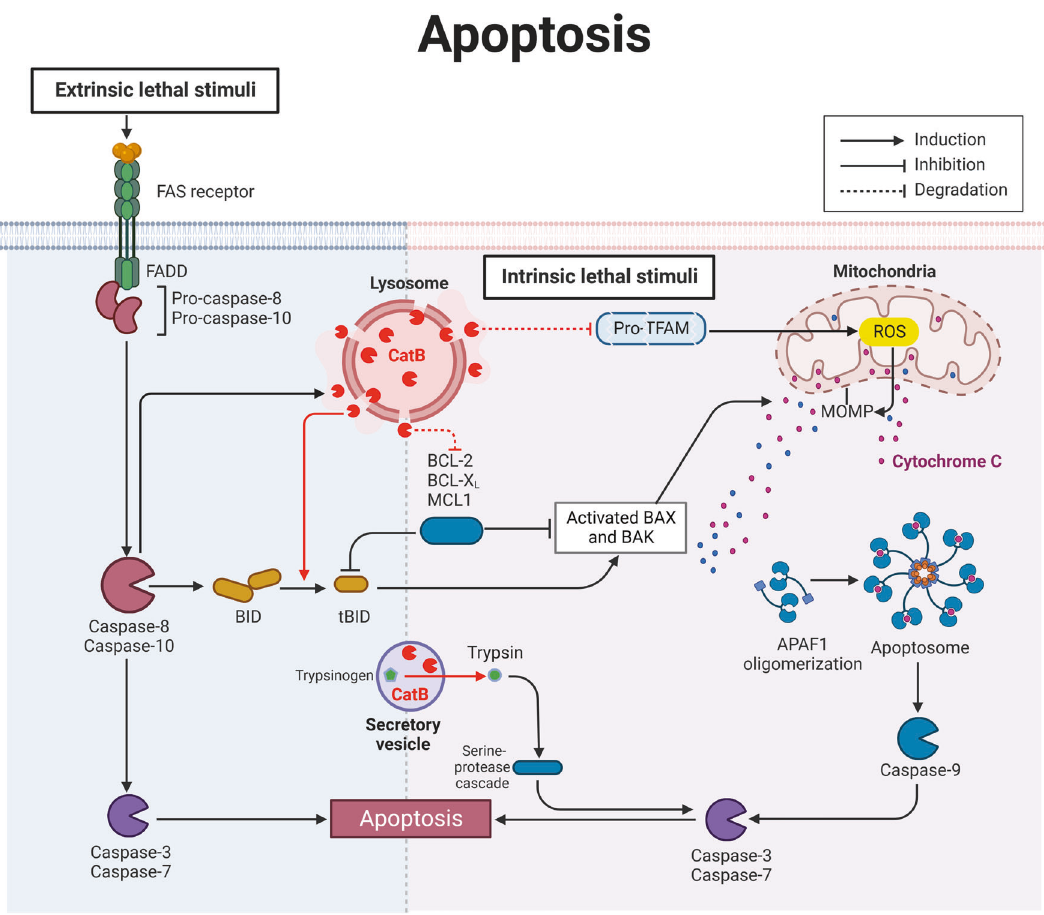
Fig. 2 Schematic representation of CatB and its substrates in the core apoptotic machinery. The extrinsic apoptotic pathway is activated by the binding of Fas ligand to the cell surface death receptor (FasR), which induces the activation of the caspase cascade. The intrinsic apoptotic pathway is activated by intracellular stress, which is initiated by BCL-2 family proteins (BAX/BAK). Mitochondria release cytochrome c. The binding of cytochrome c to APAF1 promotes apoptosome assembly, which recruits and activates caspase 9. Notably, leakage of CatB from the lysosome involves in TFAM degradation and Bid truncation, resulting in MOMP. Moreover, CatB in acidic secretory vesicles is involved in trypsin activation, which regulates the serine protease cascade, resulting in apoptosis. APAF1 apoptotic peptidase activating factor 1,